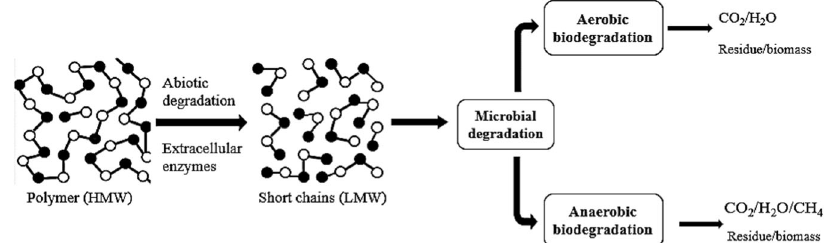
Fig. 1 The chemical biodegradation diagram. Biodegradation steps of